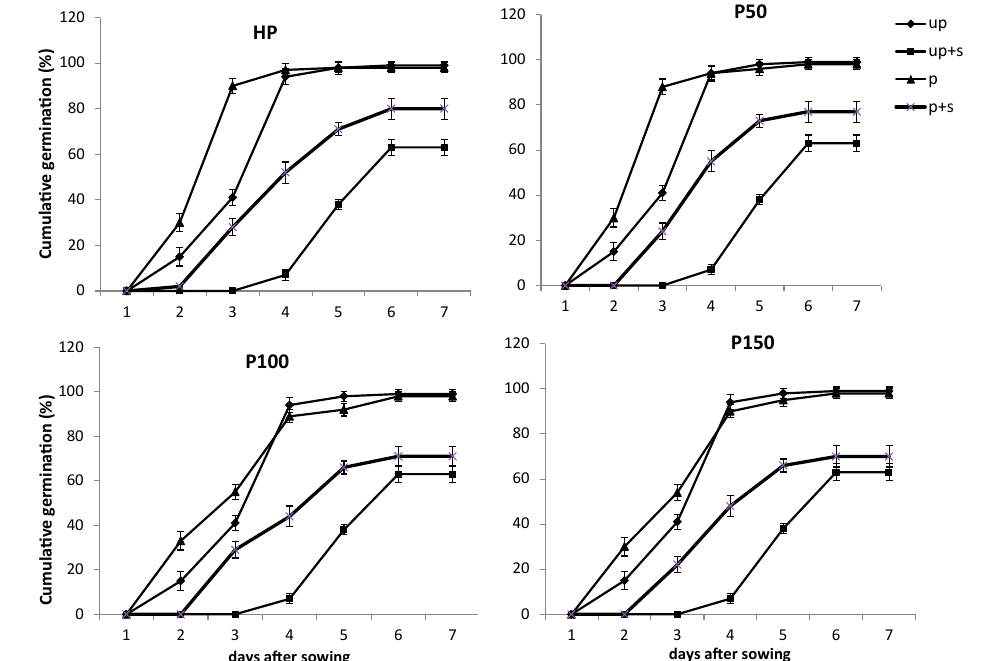
Fig. 1: Cumulative seed germination of unprimed and primed rice seeds germinated under high salinity. UP: unprimed seeds germinated under no salinity, UP+S: unprimed seeds germinated under salinity, P: primed seeds germinated under no salinity, P+S: primed seeds germinated under salinity. HP: hydropriming, P50: NaCl-priming with 50 mM NaCl, P100: NaCl-priming with 100 mM NaCl. P150: NaCl-priming with 150 mM